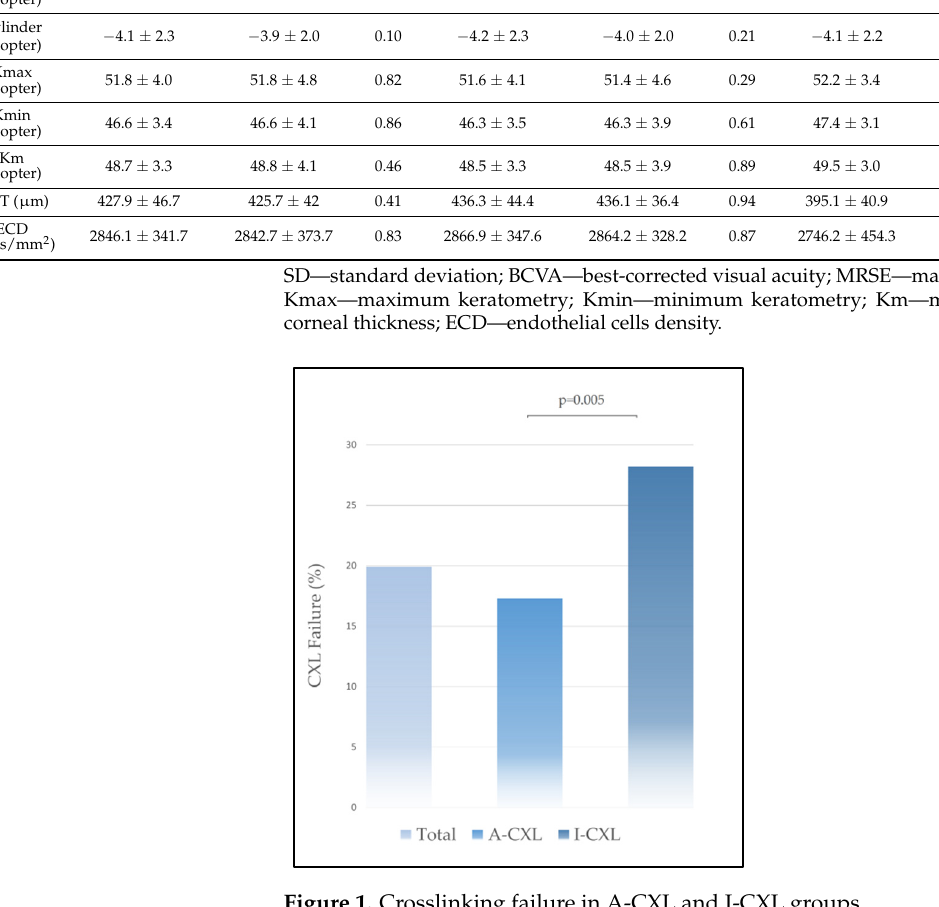
Figure 1. Crosslinking failure in A-CXL and I-CXL groups. Table 2. Outcomes change from baseline to last visit for the whole cohort and within groups. Table 3. Proportion of eyes with steepening or flattening of Kmax above 1 diopter at last visit for the entire cohort and for A-CXL and I-CXL groups showing a higher proportion of eyes with Kmax steepening above 3 diopters following